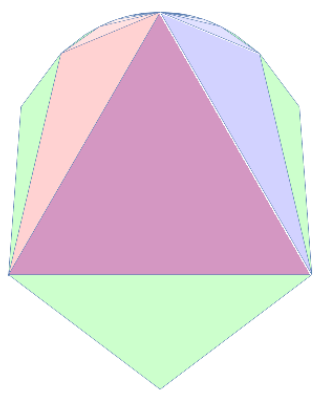
Figure 4 . A projection of the three-dimensional extended Kähler cone, K , for Example 1 . The center region is K X , the Kähler cone of the original toric phase, X . The green regions represent flops that map X to a birationally equivalent, but non-isomorphic phase, while the pastel rose and lavender regions represent flops to isomorphic phases. At the outer boundaries, D 4 , D 5 , and their infinite set of images under Λ ‘ shrink to a